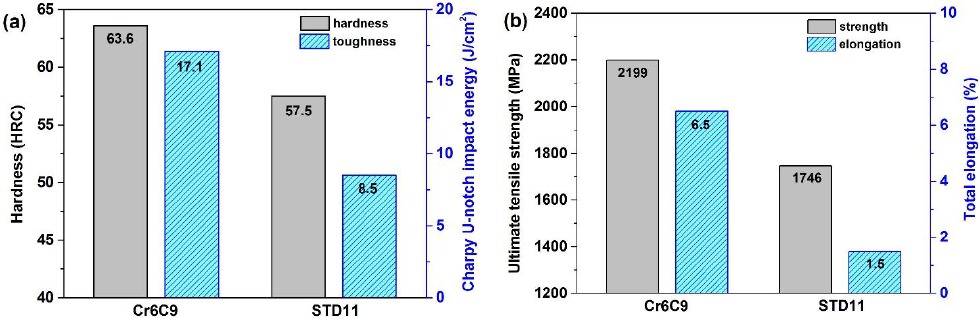
Figure 5. Comparison of the mechanical properties of the Cr6C9 and STD11 specimens: ( a ) hardness; impact toughness; and ( b ) tensile properties (ultimate tensile strength and total elongation).